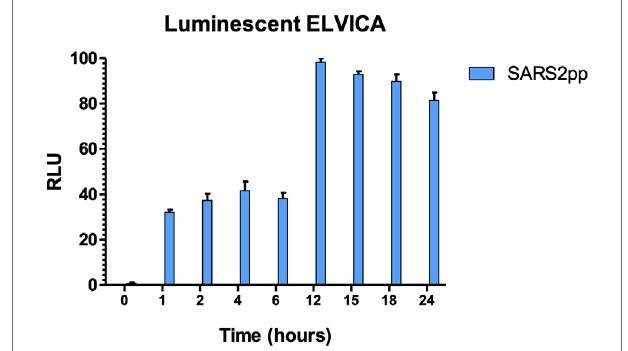
FIGURE 3 | Time-dependent sensitivity of luminescent ELVICA for detecting SARS2pp. Time-dependent sensitivity of luminescent ELVICA performed at different incubation time periods with the same concentration of